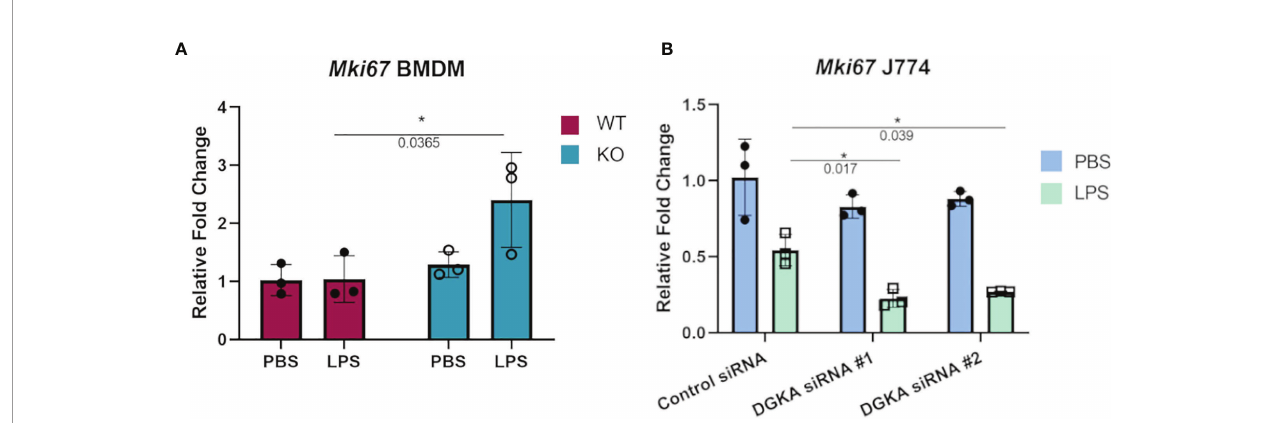
FIGURE 3 | Increased sensitivity to regulation of cell cycling with Dgka knockout/knockdown. (A) qPCR analysis of Mki67 expression in WT and Dgk a -/- BMDMs treated for 24h with 500ng/mL LPS. (B) J774 macrophages transfected with two different Dgka siRNAs were similarly assessed by qPCR for Mki67 following LPS stimulation. Each data point in (A) represents an individual mouse for n = 3 per group. Representative data are shown in (B) . Samples were normalized to PBS- treated WT or control siRNA cells. Error bars: SD. *p < 0.05; Two-way ANOVA with Tukey post-hoc